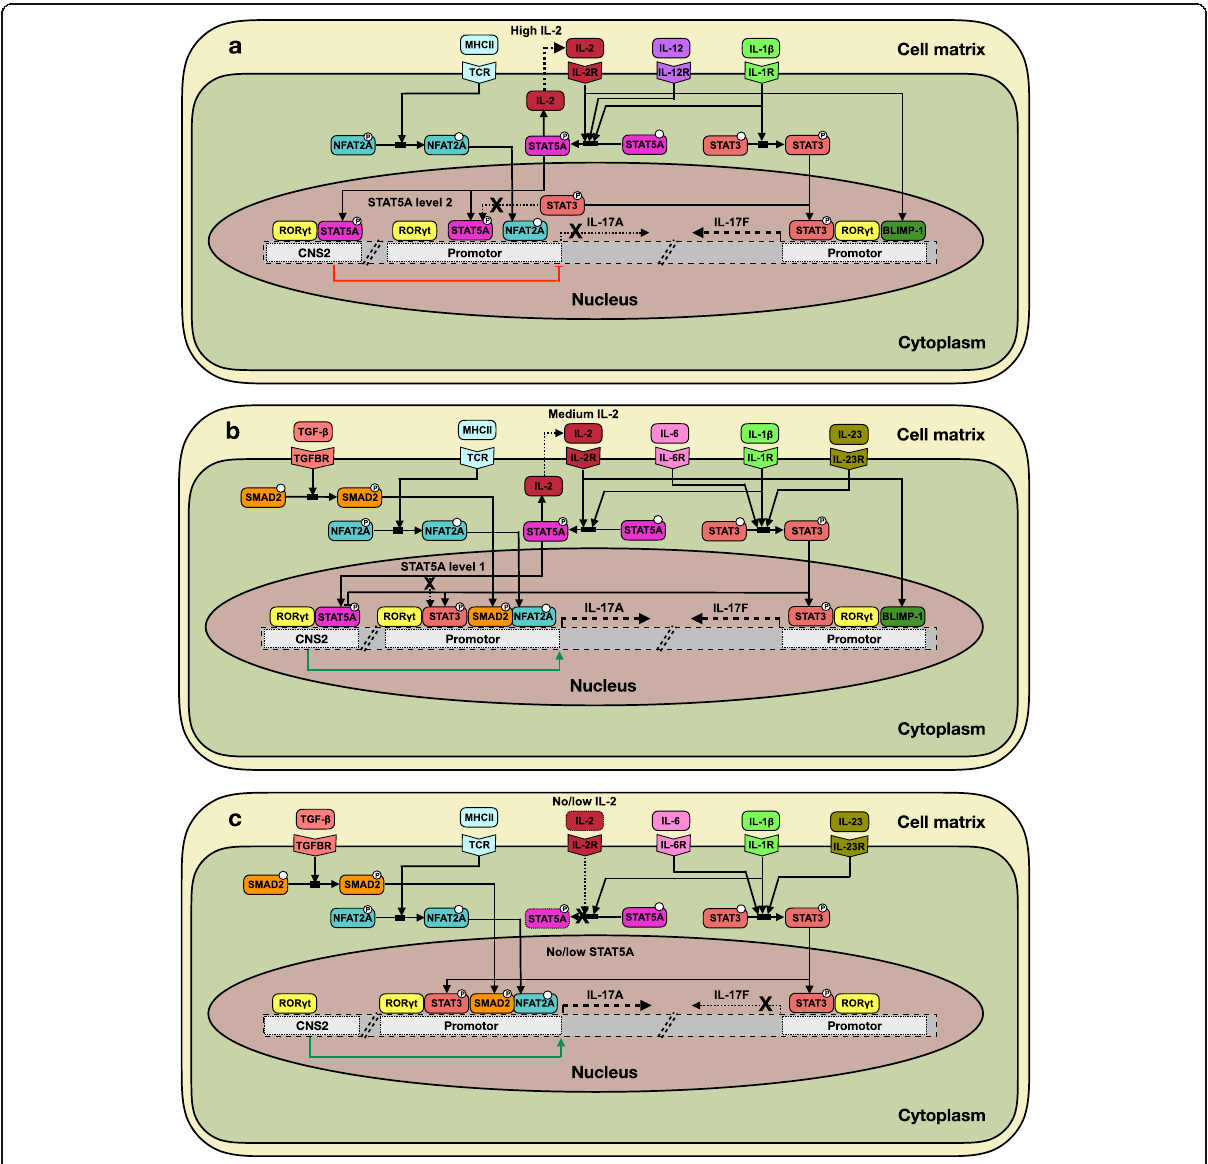
Fig. 7 Proposed regulatory mechanism for IL-17A and IL-17F differential regulation. Guided by our modeling study, we further analyzed recent publications to identify mechanisms susceptible to explain the three main cytokine input-output scenarios observed: a Expression of IL-17F, but not IL-17A under an IL-12 + IL-1 β condition. Note the autocrine loop involving IL-2. The red blunt arc denotes an enhancer-mediated inhibition of IL-17A transcription. b Expression of IL-17F and IL-17A in a proTh17 condition. The green arrow denotes an enhancer-mediated activation of IL- 17A transcription. c Expression of IL-17A, but not IL-17F in a proTh17 condition. The proposed regulatory scheme relies on the following assumptions: i) SMAD2 is required for the expression of IL-17A, ii) SMAD2 and NFAT2A over-expressions have a cooperative effect on IL-17A expression, iii) SMAD2 over-expression and STAT5A down-regulation have a cooperative effect on IL-17A expression, iv) IL-17F transcription presumably requires STAT5A, but not SMAD2 nor NFAT2A, v) STAT5A OFF inhibits IL-17F expression and a low level of STAT5A is necessary, since STAT5A is involved in BLIMP-1 activation circuit and BLIMP-1 is required for IL-17F expression but not for IL-17A